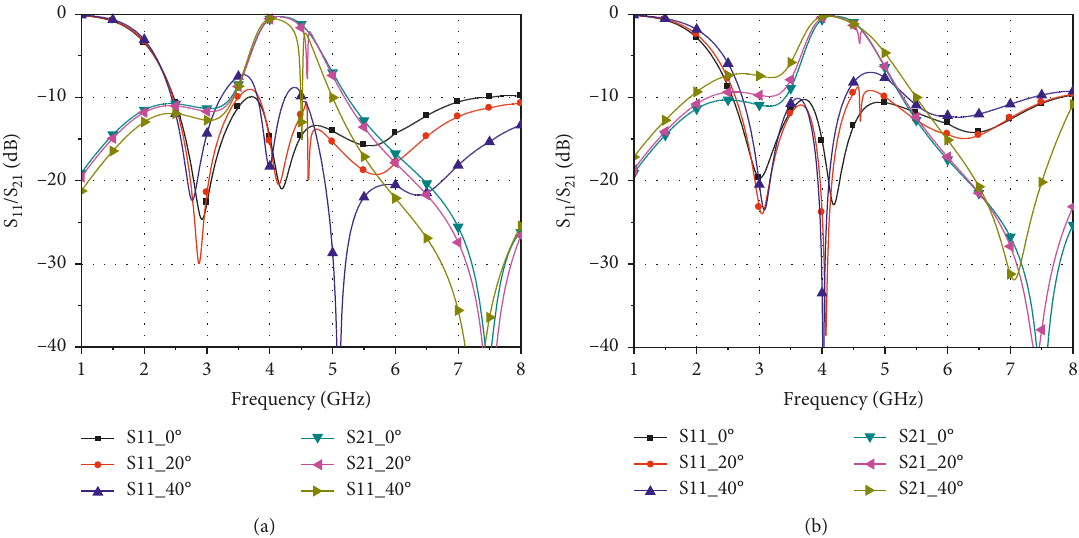
Figure 8: Simulated results of reflection/transmission coefficients of miniaturized design under different oblique incidence angles. (a) TE polarization. (b) TM polarization.